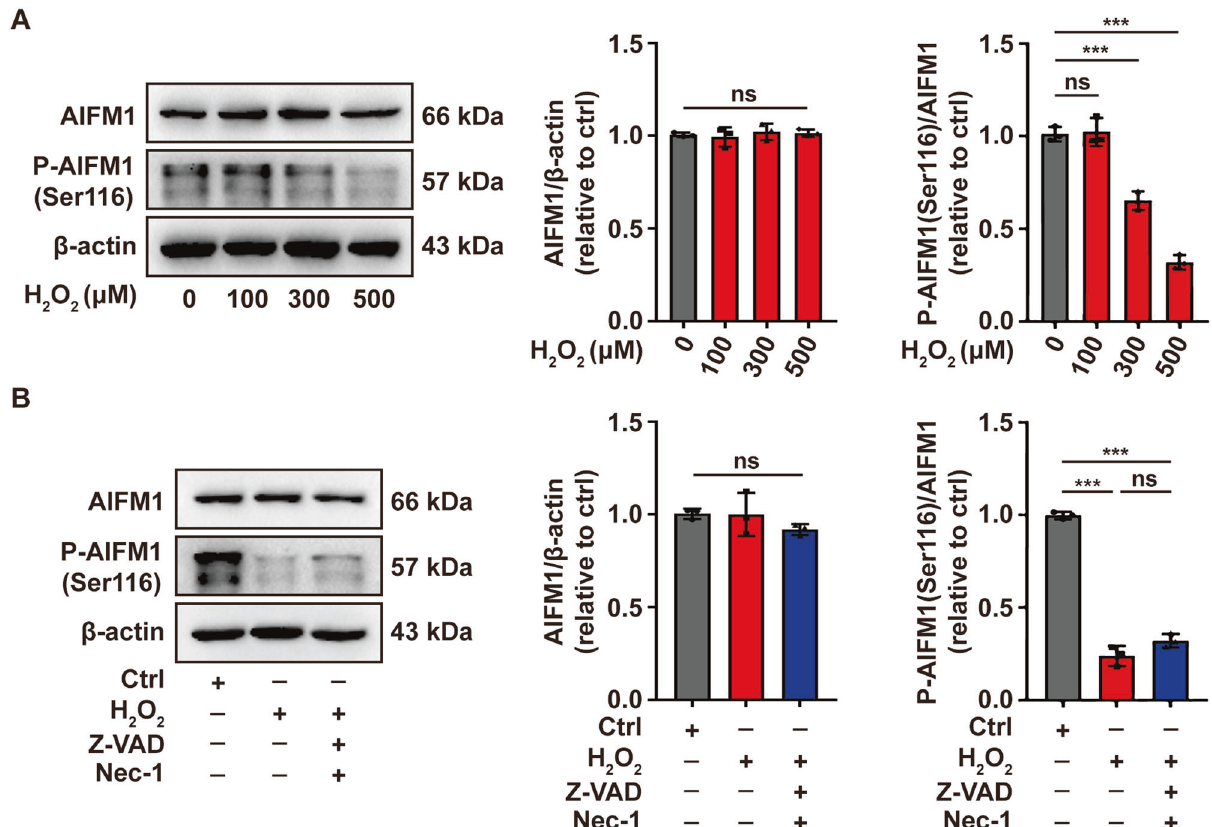
Fig. 2 Oxidative stress induces dephosphorylation of AIFM1 at Ser116 in melanocytes. Western-blot assay of AIFM1 phosphorylated at Ser116 in PIG1 cells treated by the indicated concentration of H 2 O 2 ( A ) or pretreated with Z-VAD and Nec-1, followed by treatment with H 2 O 2 ( B ). *** P < 0.001, ns: not signi fi